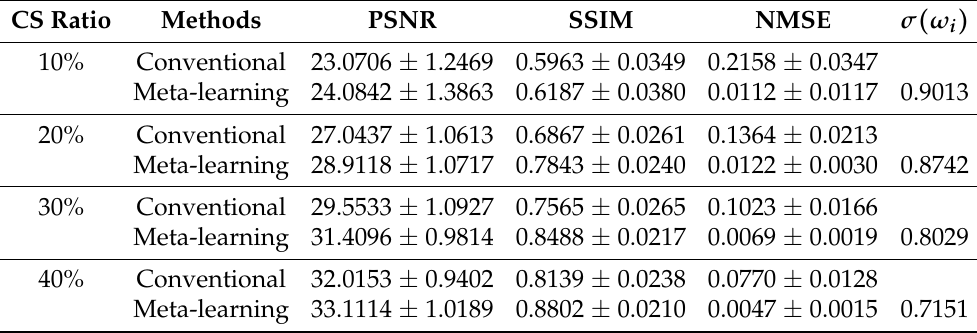
Table 2. Quantitative evaluations of the reconstructions of T2 brain image associated with various sampling ratios of radial